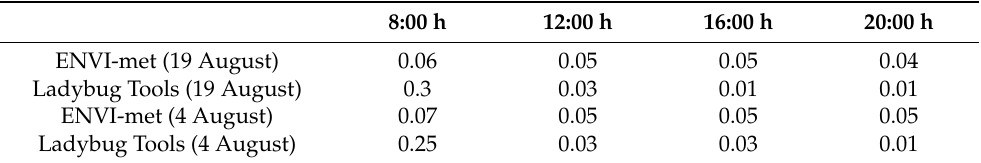
Figure 10. Mean radiant temperature and relative humidity results of each workflow in the middle of the courtyard at 1.5 m above the ground on the two simulated days. Table 5. Wind speed (m/s) results of each workflow in the middle of the courtyard at 1.5 m above the ground on the two simulated